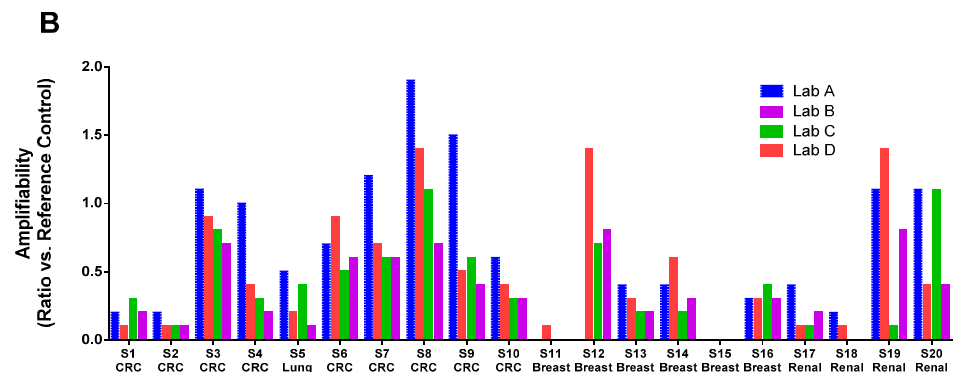
Figure 2. Amplifiability of DNA extracted by different labs measured by Asuragen Quantitative Functional Index (QFI) ( A ) and RNase P ( B ) assays. S12 from Lab A was run out and quality control (QC) data is not available. Missing data for S11 is due to poor FFPE block quality and high fat content of the breast tissue. CRC: colorectal cancer.